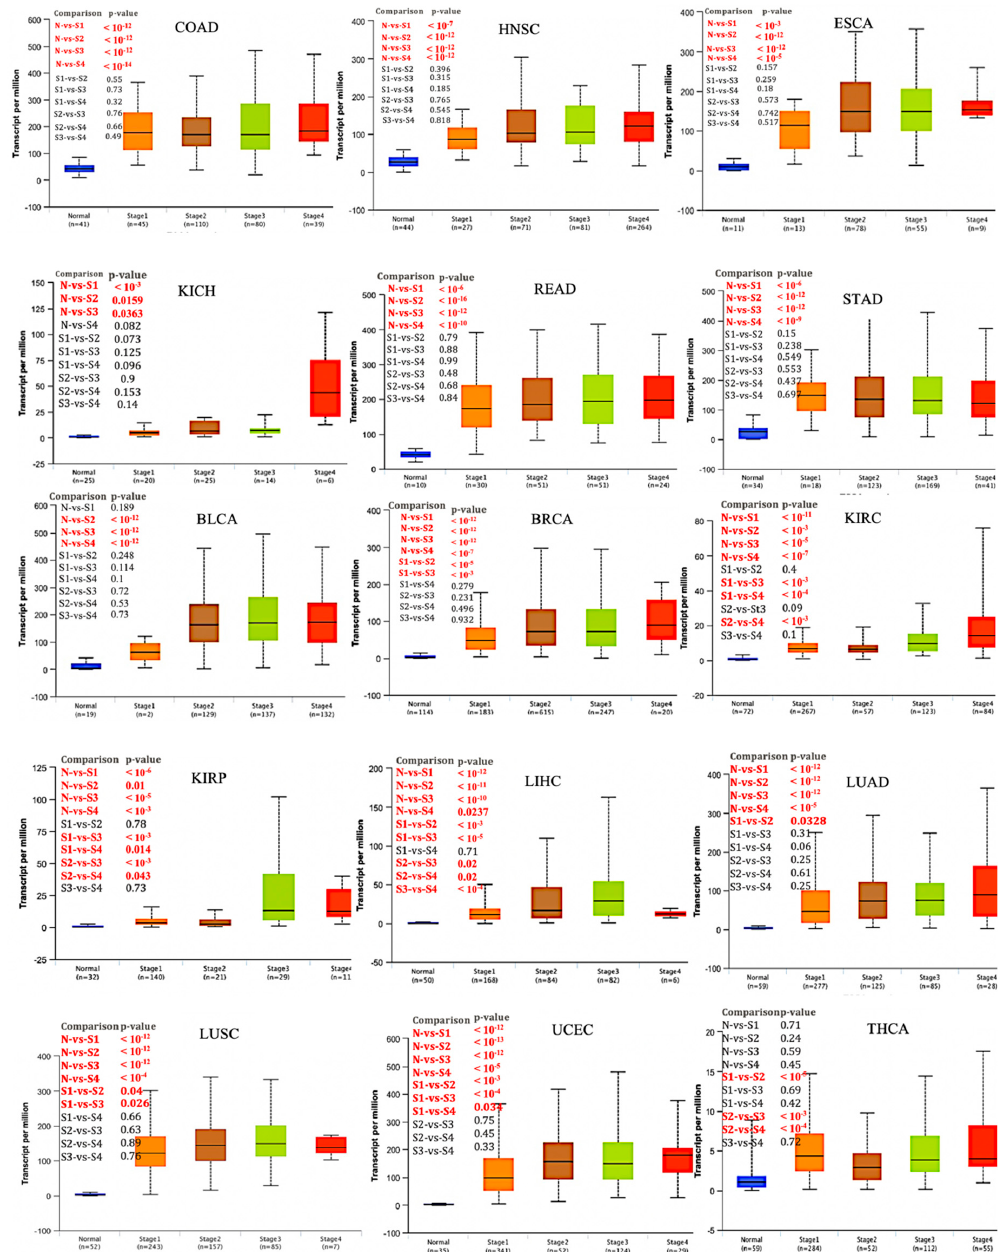
Figure 2. UBE2C expression based on individual pathological cancer stage. Box plot reveals that the over-expression of UBE2C may have role in initiation of COAD, HNSC, ESCA, KICH, READ, STAD, and BLCA, but not in progression since significant changes were observed only between normal and pathological stages not between each stage. The expression of UBE2C in BRCA, KIRC, KIRP, LIHC, LUAD, LUSC, and UCEC shows its involvement in both cancer initiation and progression. Regarding THCA, while there were no significant changes between normal and pathological stages, it seems that UBE2C is involved in progression from stage 1 to 2 and then 2 to 3. Y axis: transcript per million, X axis: pathological cancer stages with the number of samples in each stage in parenthesis. N: normal, S: stage.